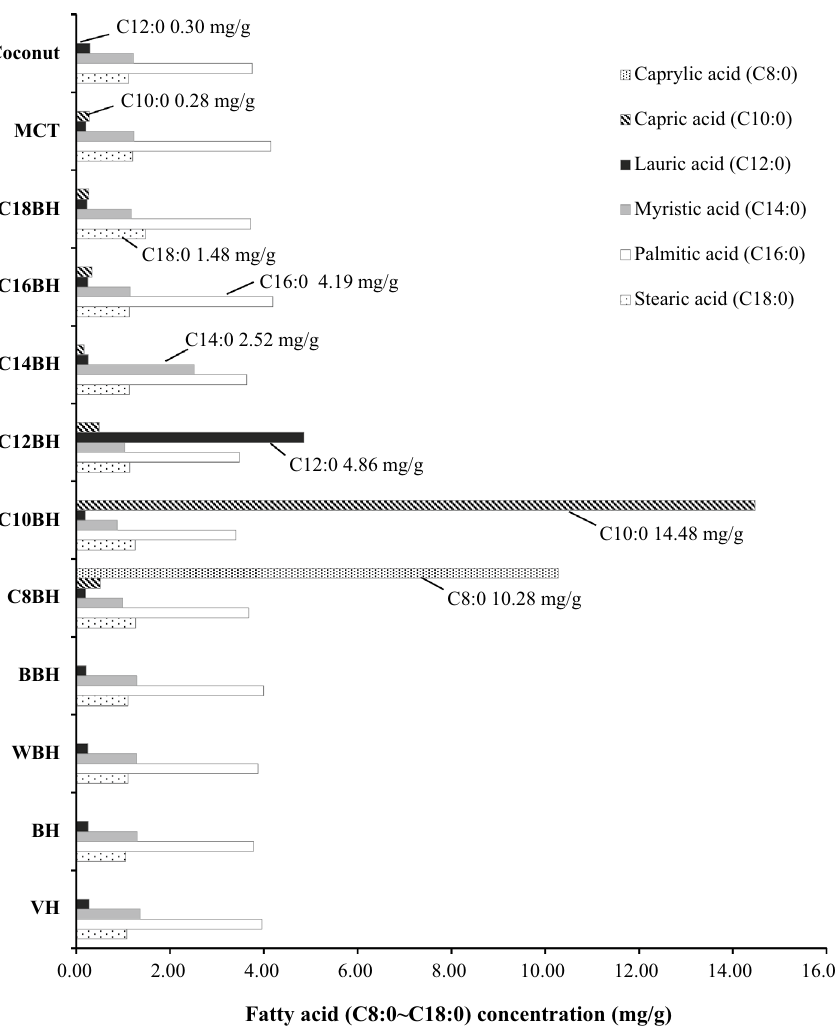
Fig. 3 Result of GC–MS analysis on the C8:0–C18:0 fatty acid concentration of hair samples. VH, BH were untreated and WBH–Coconut were after 21 days of